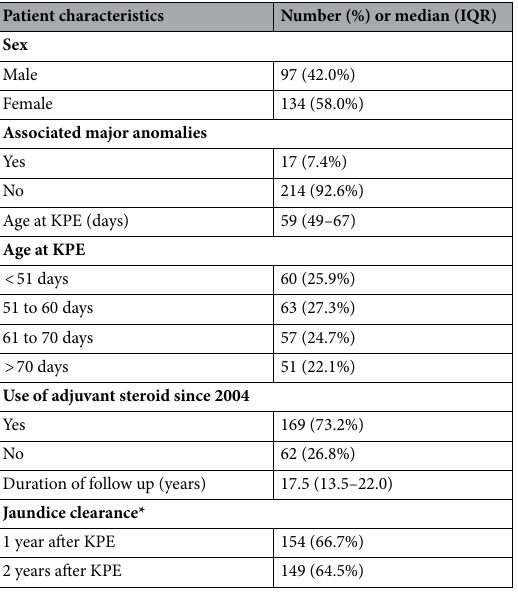
Table 1. Demographic data and clinical outcomes of 231 BA patients with open KPE performed in Hong Kong between 1980 and 2017. *Failure of clearance of jaundice (COJ) is defined as serum bilirubin > 20 µmol/L or transplanted.